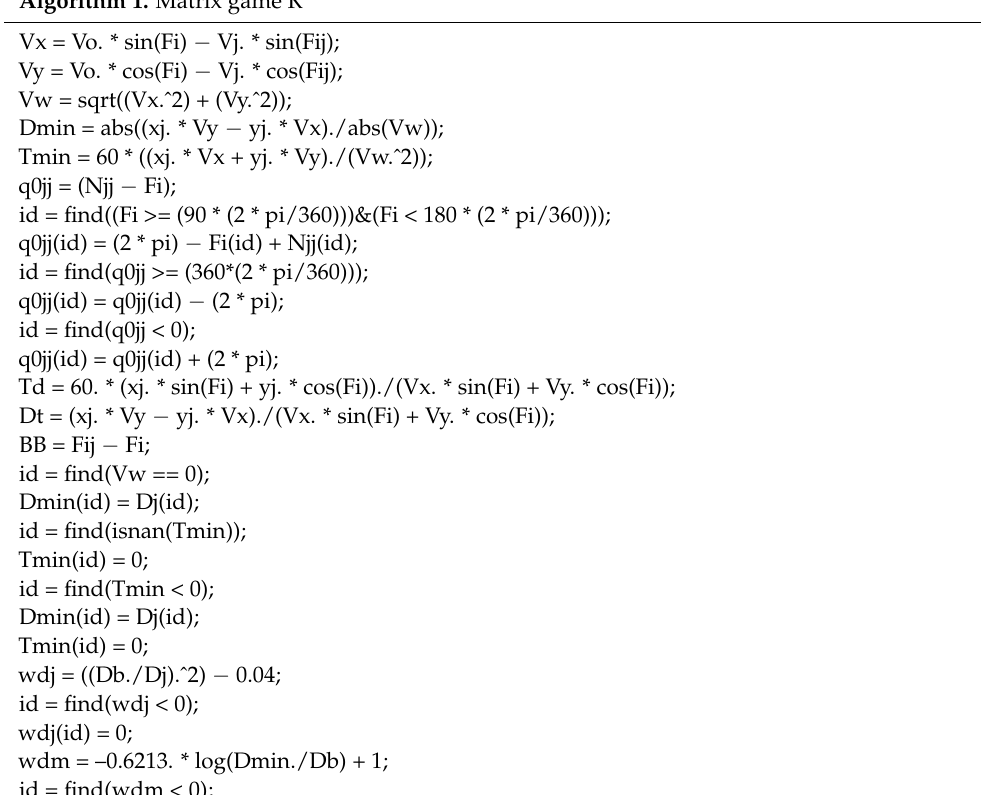
Algorithm 1. Matrix game